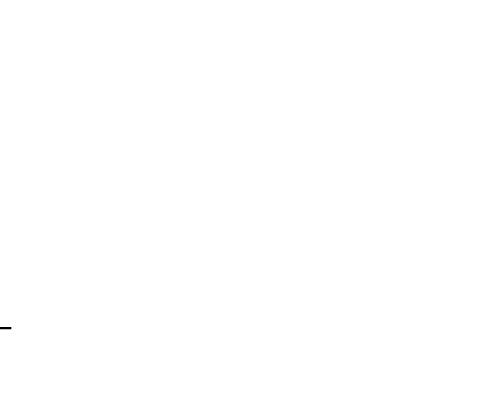
Figure 7. Effects of NMDA ( A ) and AMPA ( B ) receptors activation on Mg 2+ -ATPase activity in neo- natal cortex 5 days after HIS (PD 17). The activity of Mg 2+ -ATPase was measured in control rats (PD 17) and after HIS (PD 17), following the protocol described in the Materials and Methods section. To evaluate the influence of NMDA and AMPA receptor activation on Mg 2+ -ATPase activity, the corresponding plasma membranes were preincubated for 6 min at 30 °C with 140 μ M of NMDA